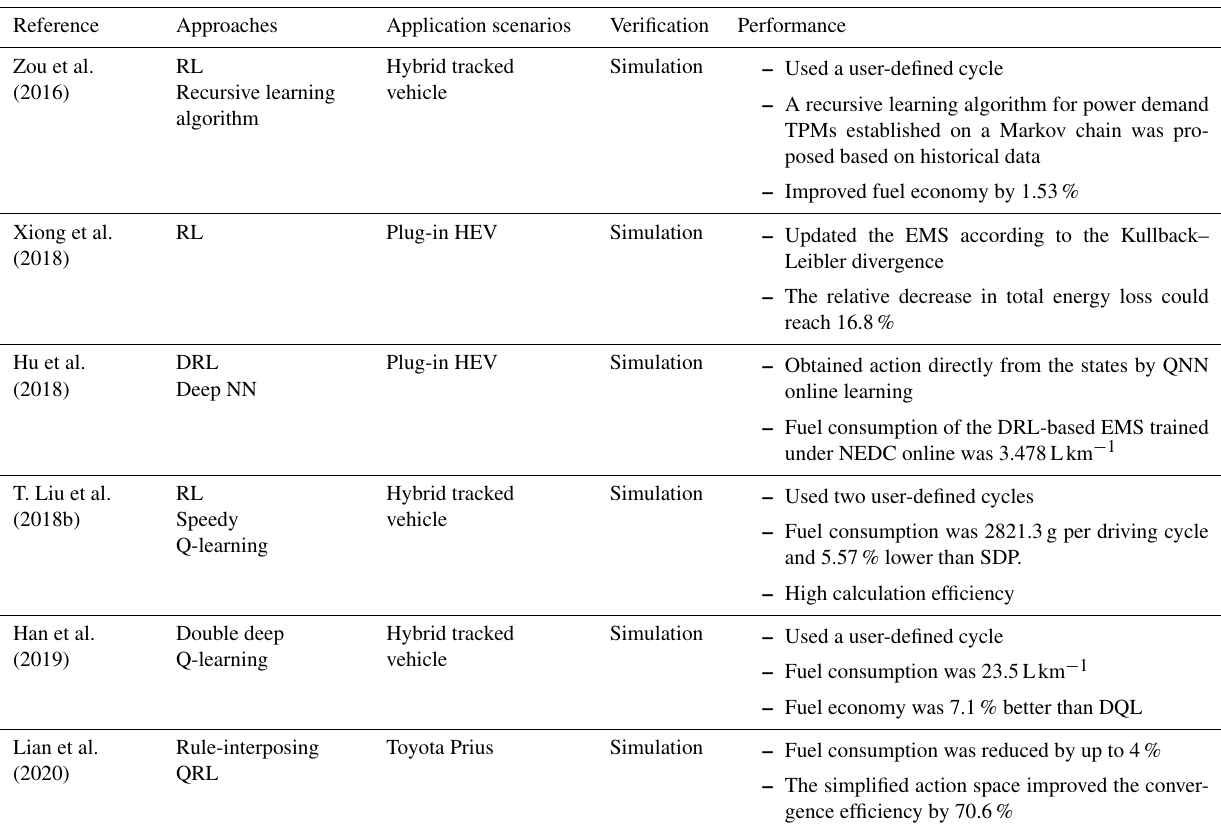
Figure 12. A schematic diagram of an RL-based EMS. Table 13. Summary of exemplary works on RL-based